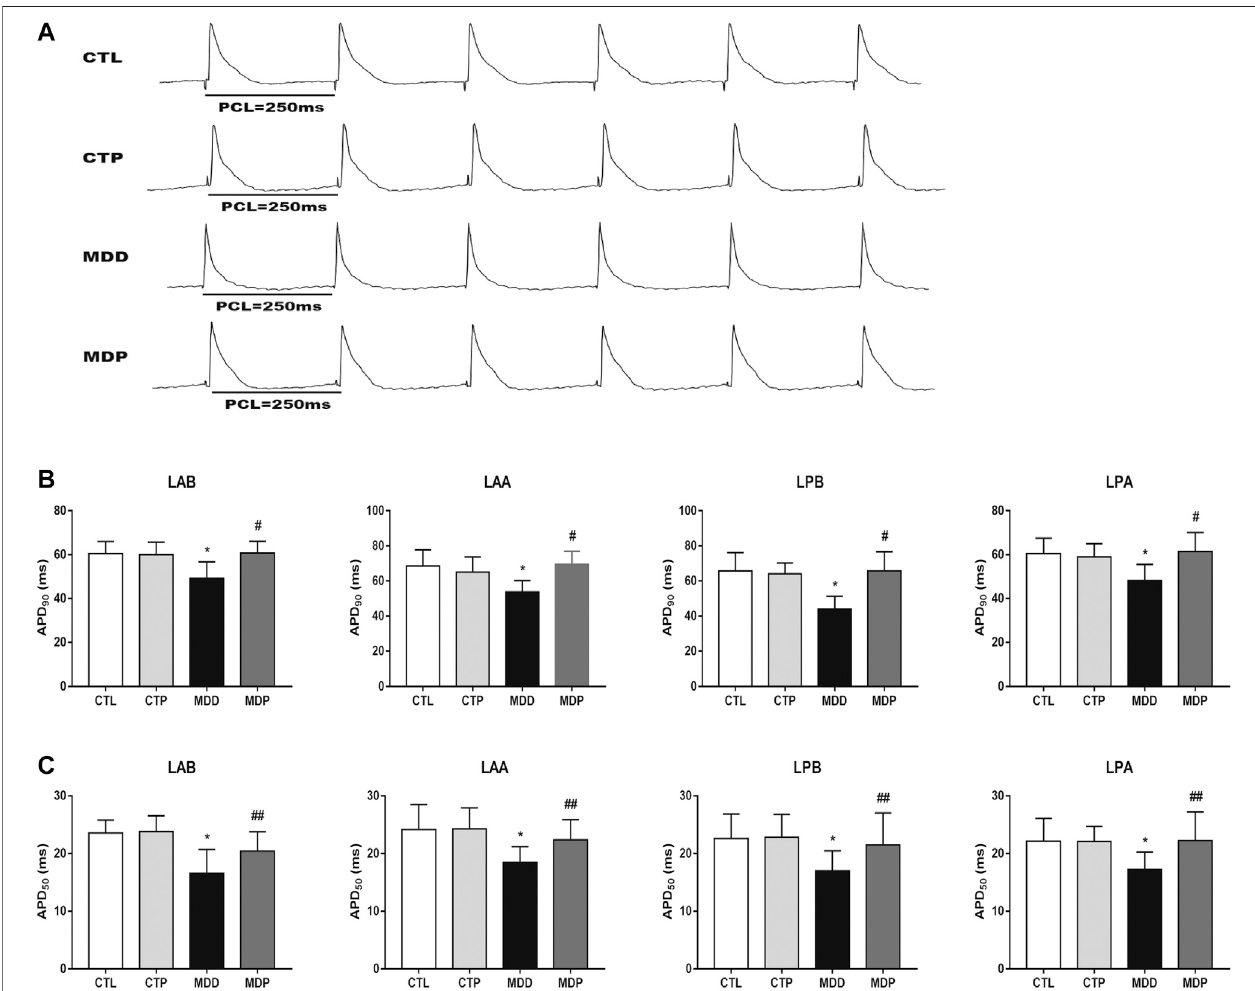
FIGURE 4 | Ventricular repolarization. (A) Representative recordings of APD at PCL of 250 ms. (B,C) APD 90 and APD 50 at four epicardial sites at PCL of 250 ms, respectively.n (cid:1) 10pergroup.* p < 0.01vs.CTL;# p < 0.01vs.MDD;## p < 0.05vs.MDD.PCL,pacingcyclelength;APD 90 andAPD 50 ,actionpotentialdurationat90% repolarization and 50% repolarization,